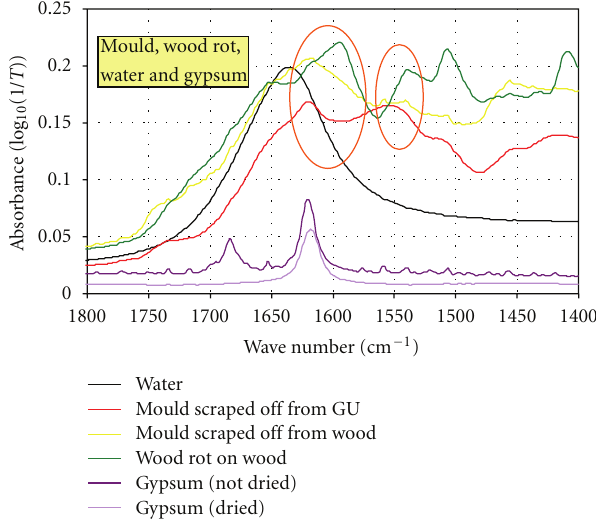
Figure 6: Absorbance (logarithmic) versus wave number between 1800–1400 cm − 1 for mould fungi on GU plaster board, mould fungi on a wood sample, and wood rot at selected exposure levels. In addition, the water, nondried gypsum and dried gypsum spectra are also plotted as a comparison. From Figure 5 (except gypsum spectra). See discussion in text about the FTIR absorbance peaks within the large (left) and small (right) ellipse encircling the absorbance